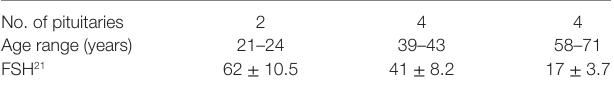
TABLe 3 | Relative abundance of FSH 21 in individual human